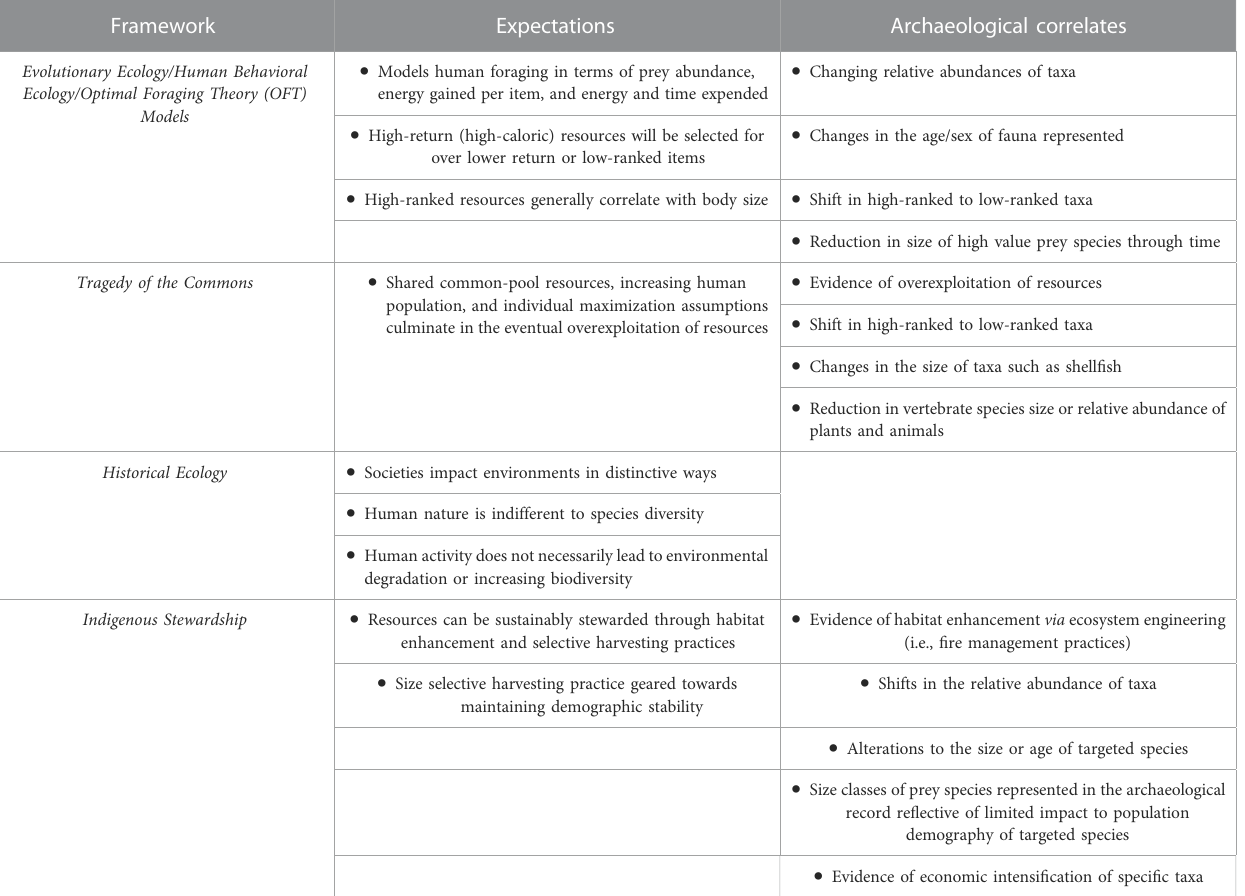
TABLE 1 Expectations and archaeological correlates of human-environmental relationships in Evolutionary Ecology, the Tragedy of the Commons, Historical Ecology, and Indigenous Stewardship.